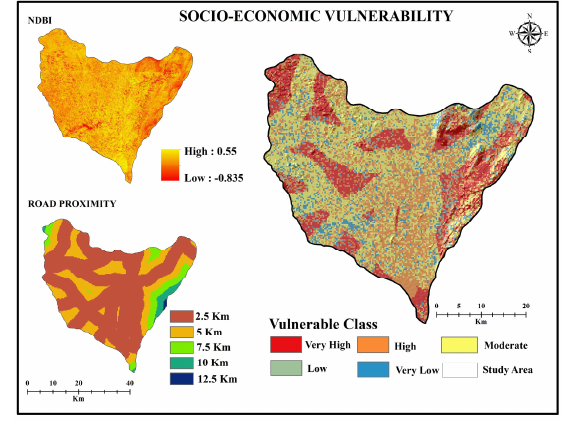
Figure 5. Socio-Economic